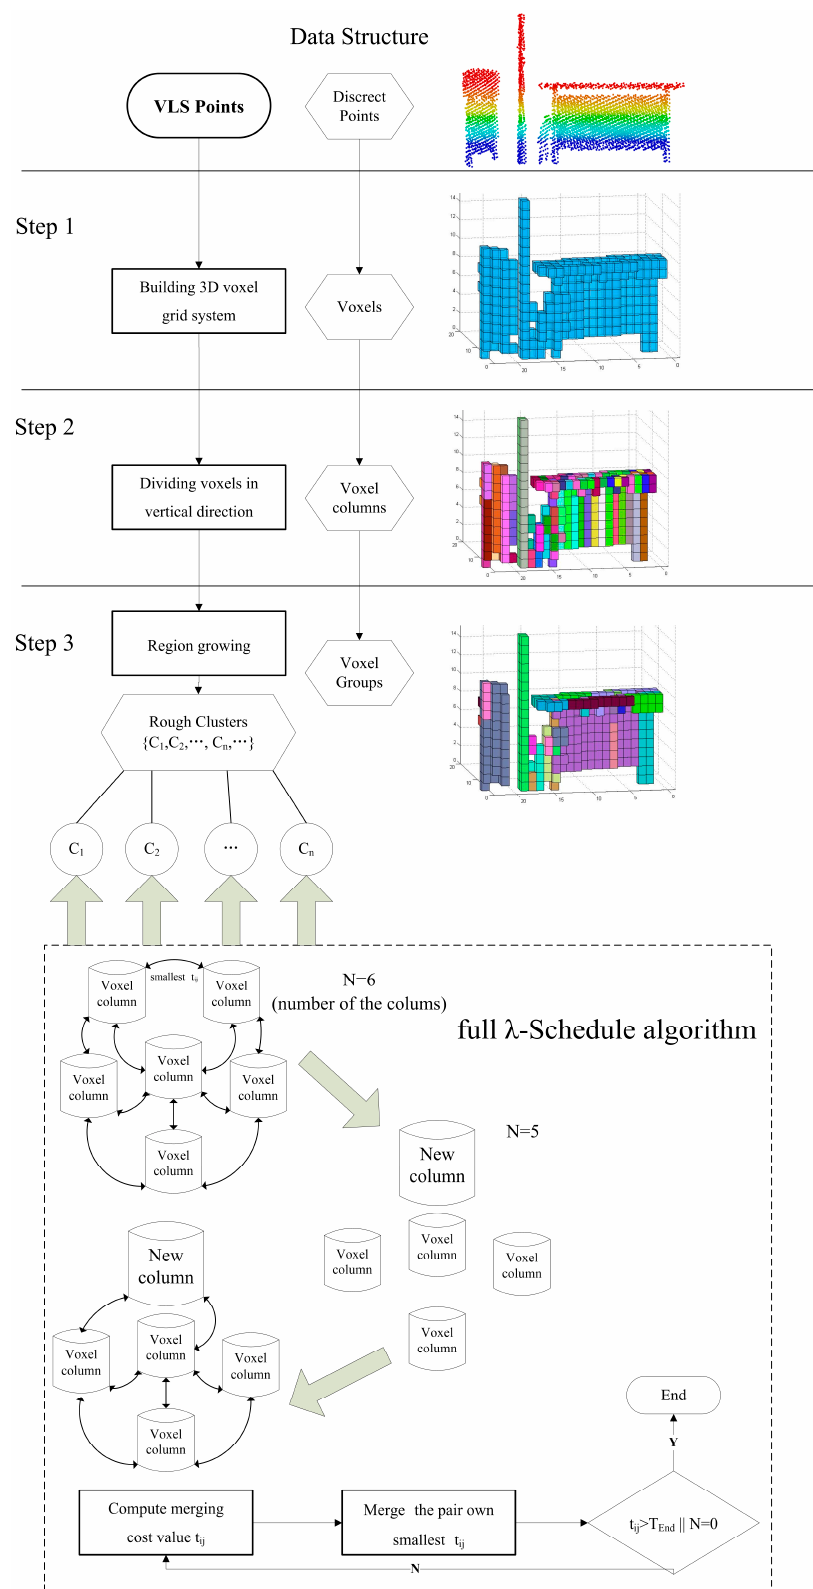
Figure 3. Flowchart of generating of voxel groups.